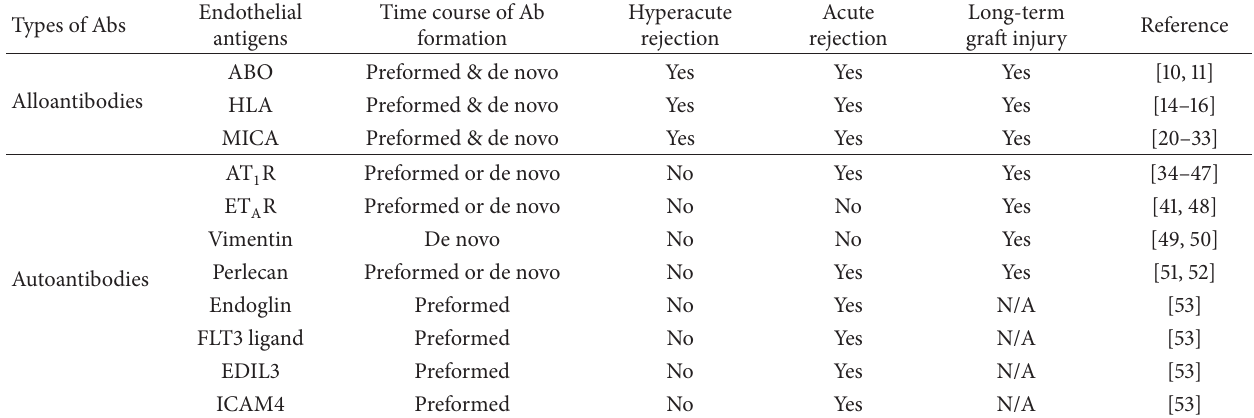
Table 1: Endothelial antigens in antibody-mediated immune